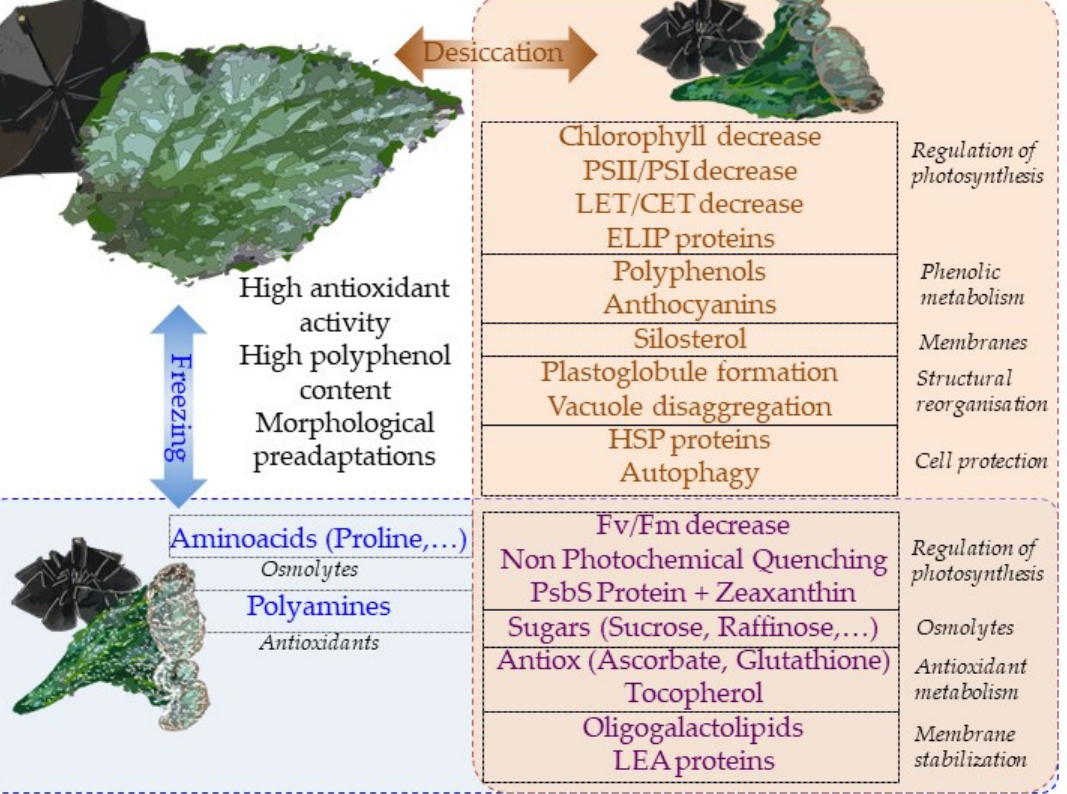
Figure 5. A summary of the main mechanisms of tolerance to desiccation and freezing in gesneriads. Brown box includes the responses to desiccation while blue box contains the mechanisms activated in response to freezing. The intersection between both boxes contains the mechanisms which are common to both stresses. Constitutive traits of gesneriads that might favor cross-tolerance are shown out of both boxes. The foldable umbrella analogy is depicted in the background.